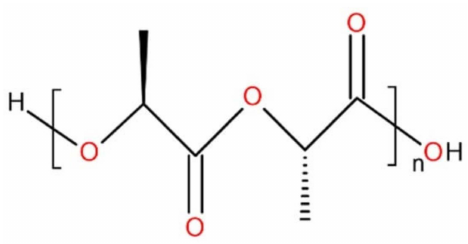
Figure 2. PLLA chemical structure (n—number of repeating